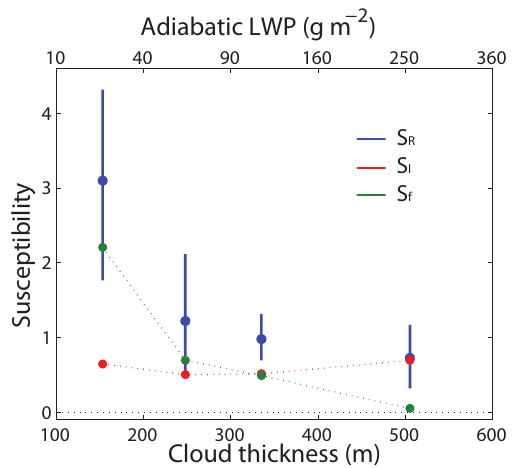
Fig. 3. The precipitation susceptibility (blue), the susceptibility of drizzle intensity (red), and the susceptibility of drizzle fraction (green) are calculated in each of the four equally weighted cloud thickness bins. Error bars on the precipitation susceptibility indicate the 95% confidence interval calculated using bootstrap resampling technique. The dotted lines exist only to identify points that lie on top of each other. The precipitation susceptibility (blue) is approx- imately the sum of the susceptibility of drizzle fraction (green) and the susceptibility of drizzle intensity (red). The adiabatic liquid wa- ter path axis on the top is estimated from cloud thickness values, us- C w h 2 , where C w = 2 × 10 − 6 kgm − 4 ing the relationship LWP = 1 2 (Pawlowska and Brenguier,